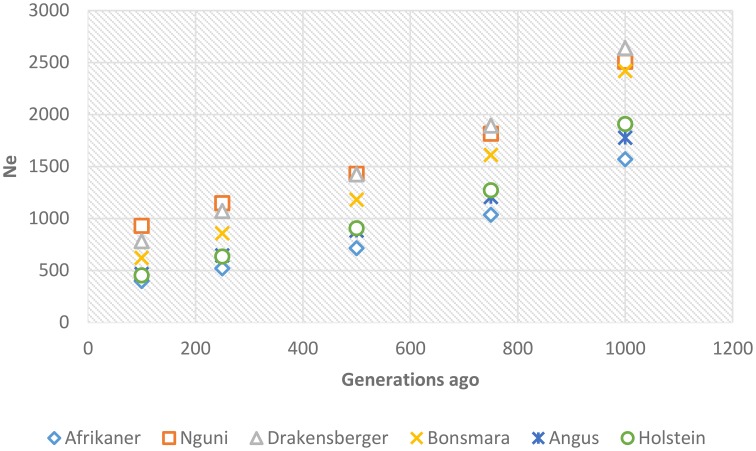
Genome-wide estimates of historical effective population size (Ne) over the previous 1000–100 generations based on estimates of linkage disequilibrium.